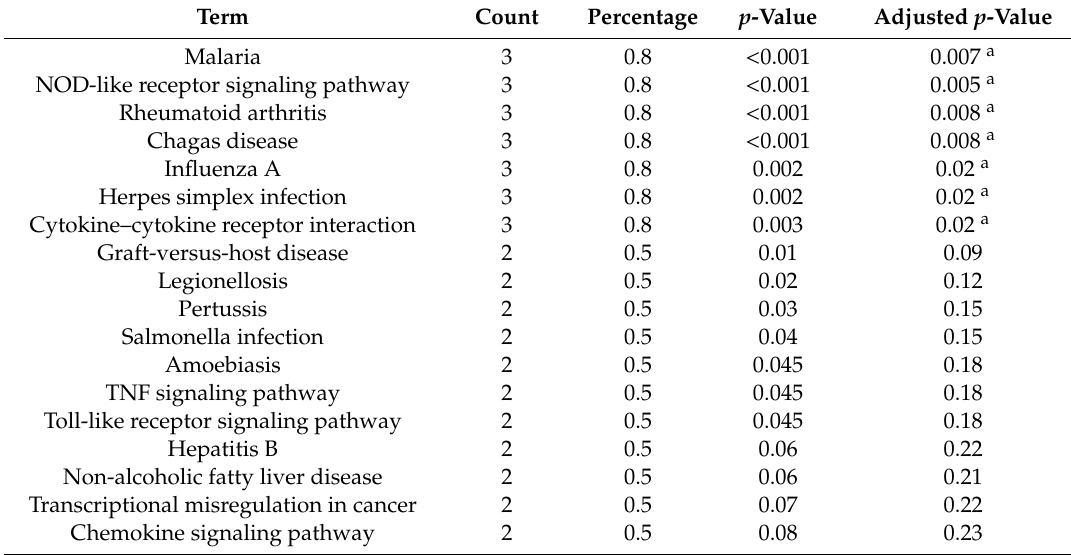
Table 3. Functional annotation chart of the Kyoto Encyclopedia of Genes and Genomes according to the five Alzheimer’s disease-associated di ff erentially expressed genes in severe OSA